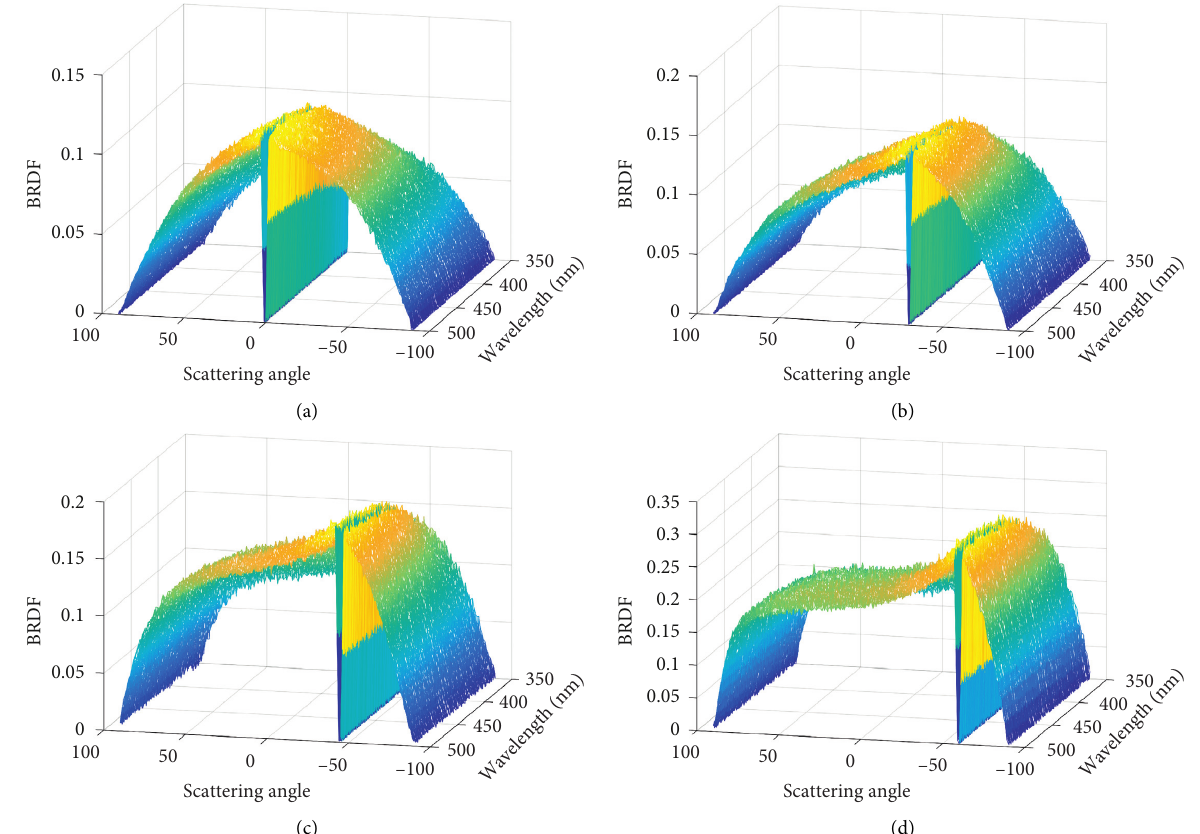
Figure 6: 3D graph of sample 3. (a) 3D data of 0 ° incident angle; (b) 3D data of 30 ° incident angle; (c) 3D data of 45 ° incident angle; (d) 3D data of 60 ° incident